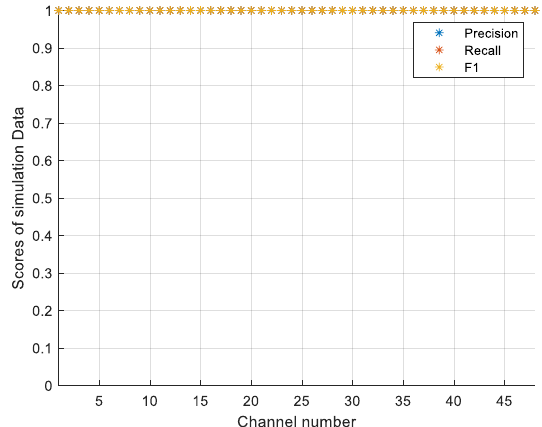
Figure 19. The ResNet-18 validation results (precision, recall and F1) of simulation data of all 48 hydrophones.